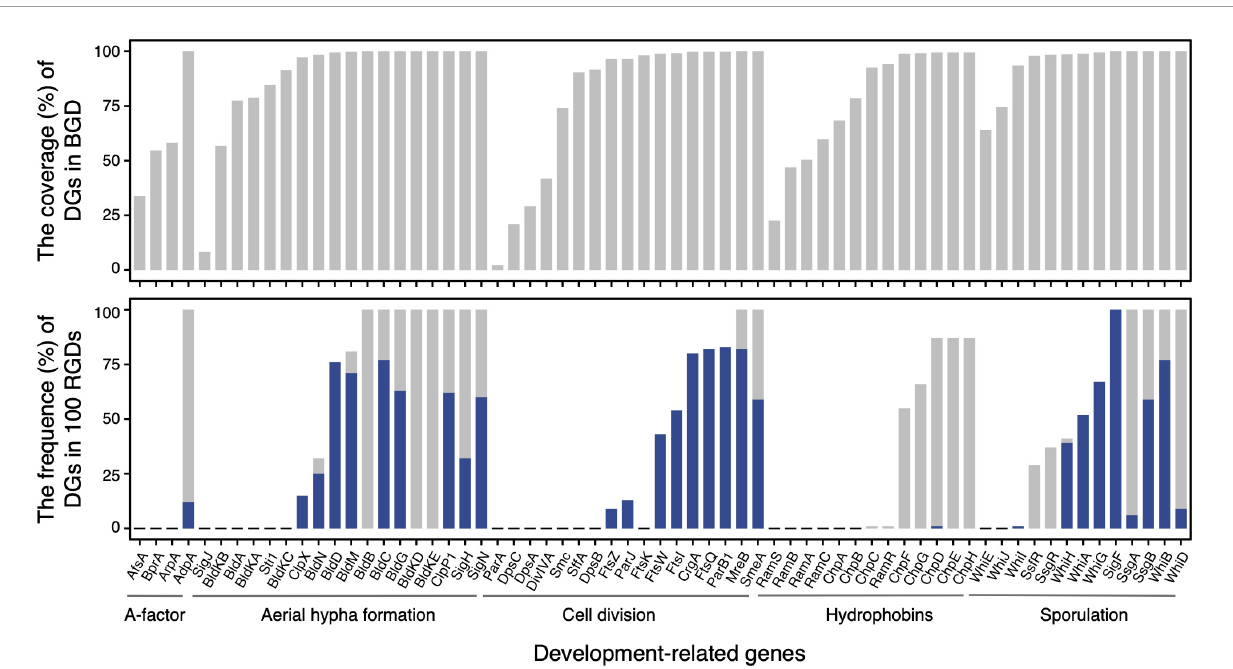
FIGURE2 The distributions of development-related genes in the basic genome dataset (upper panel) and 100 random genome datasets (lower panel) . In the lower panel, the frequencies of genome dataset (DG) as core gene family (having homolog in each genome) and strict orthogroup (subfamily assessed by UPhO) are visualized as gray and blue bars,